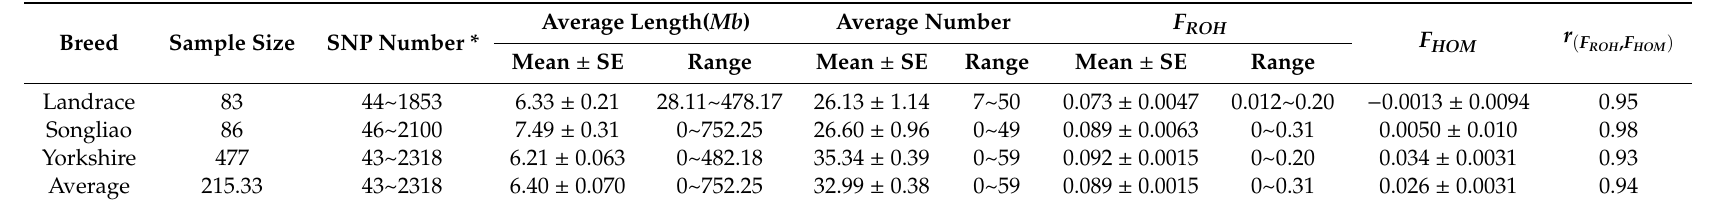
Table 2. Descriptive statistics for runs of homozygosity and inbreeding coe ffi cients (F) within each